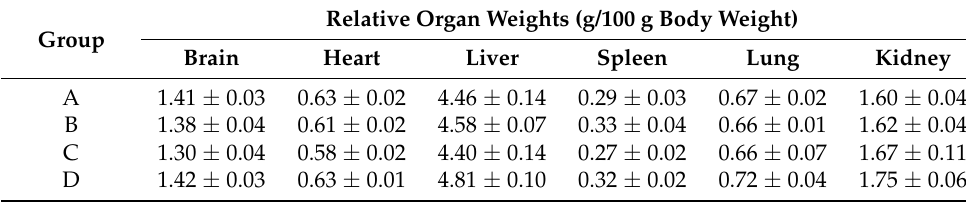
Table 3. Effects of SPE treatment on organ weights of male SAMP8 mice. Relative Organ Weights (g/100 g Body Group